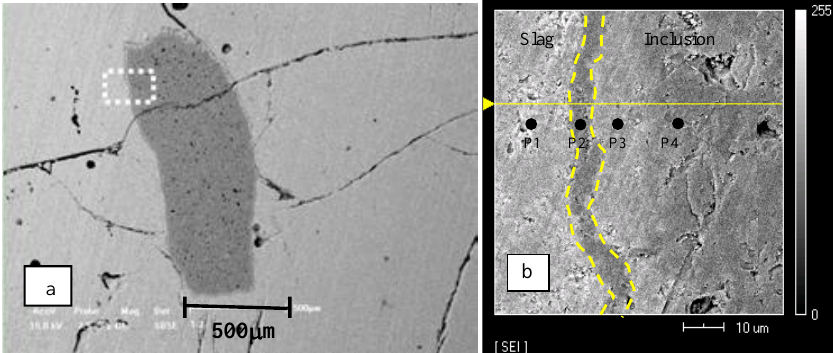
Figure 3. Results of ( a ) Typical morphology of alumina particle in slag S1 by SEM-SBSE and ( b ) line-scanning image of boundary layer.